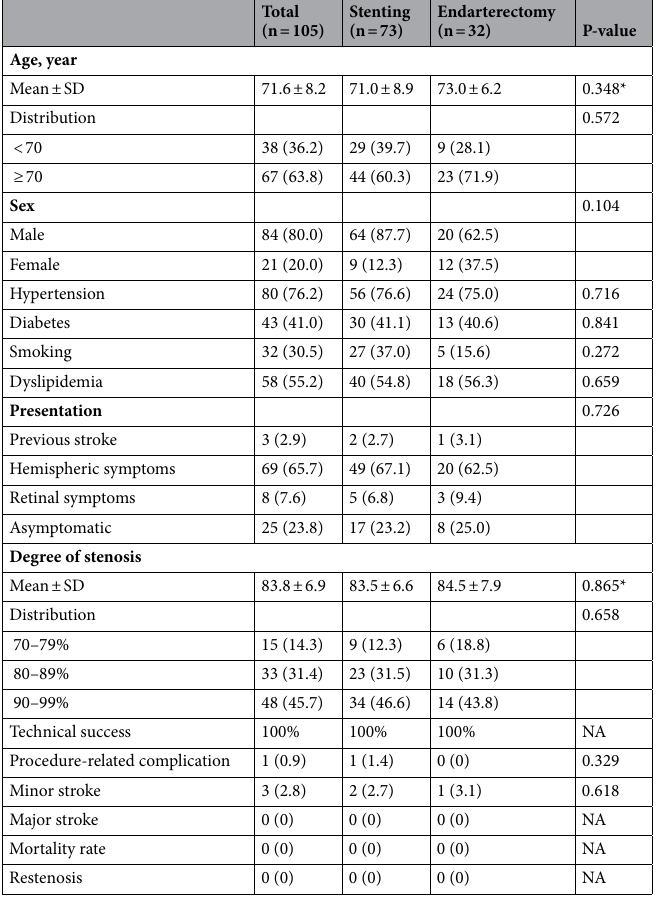
Table 2. Demographic characteristics and clinical results up to 12-month follow-up. MI myocardial infarction, NA not applicable, SD standard deviation. P-value, Chi-square test or Fisher exact test. *Student